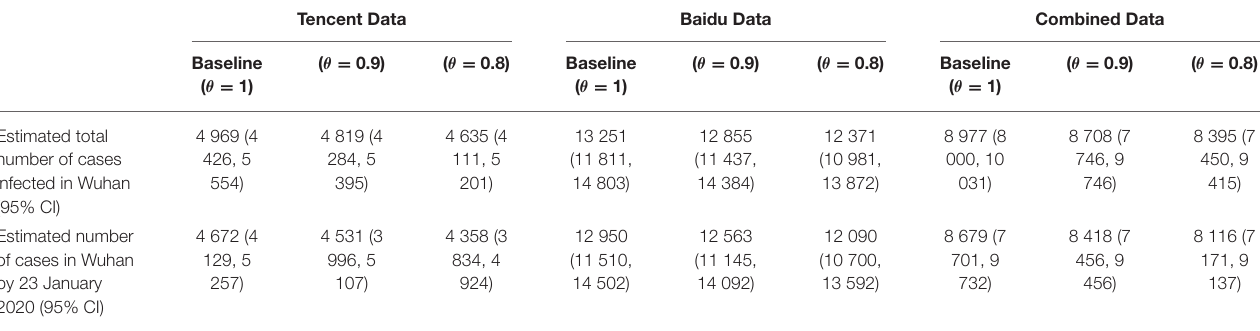
TABLE 2 | Summary table of estimated total number of cases infected in Wuhan (including cases exported from Wuhan to other cities/regions) and number of cases in Wuhan (excluding cases exported from Wuhan to other cities/regions) by 23 January 2020, from different sources of data. Tencent Data Baidu